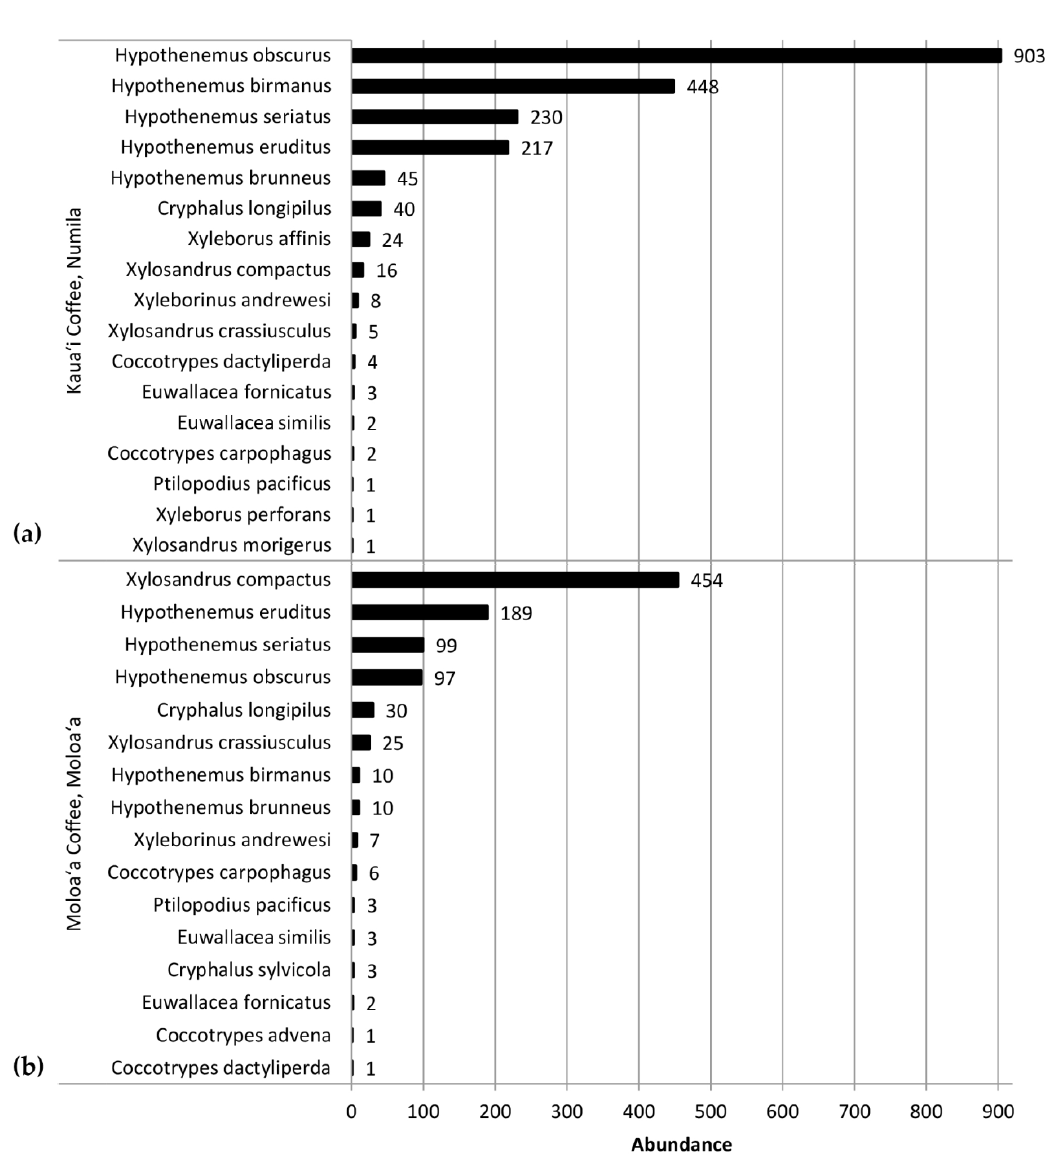
Figure 1. Abundance of scolytines collected at ( a ) the Kaua ʻ i Coffee Company and ( b ) Moloa ʻ a Bay Coffee during the 2016–2017 growing season.